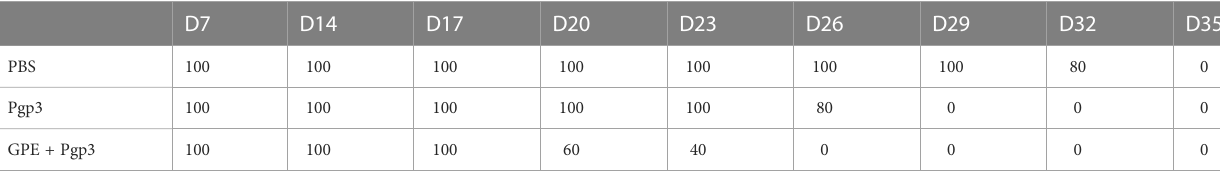
TABLE 2 Percentage of IFU-positive mice post C. muridarum